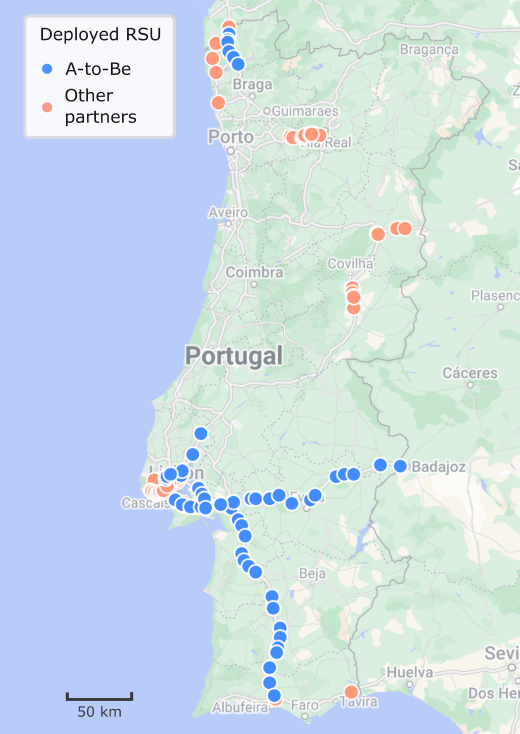
Figure 6. Deployment scenario of the C-ITS infrastructure in Portugal. Each dot corresponds to a deployed